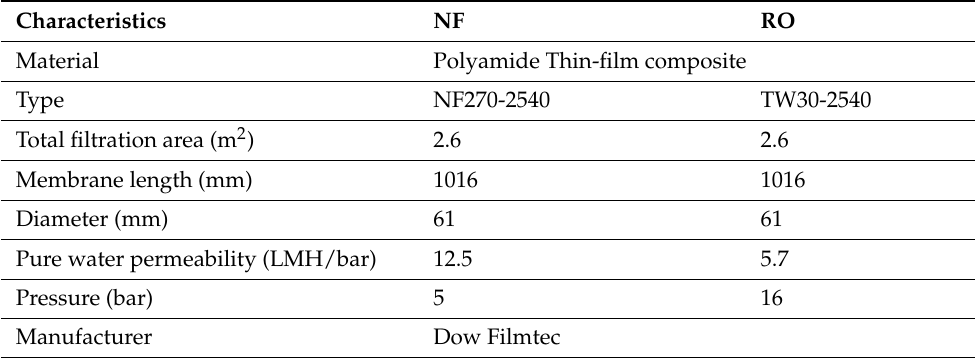
Figure 2. Nanofiltration and reverse osmosis pilot. Table 1. Membrane